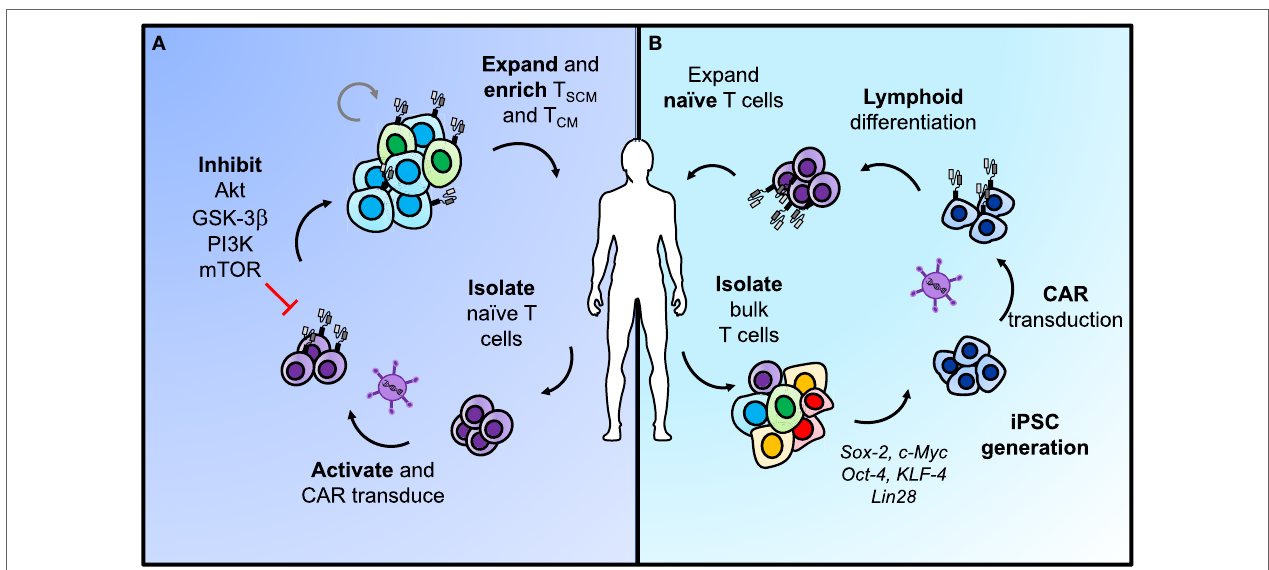
FigURe 4 | Two approaches for generating less-differentiated T cells after ex vivo expansion for adoptive cell transfer. (A) Naïve T cells sorted from peripheral blood can be activated and transduced with chimeric antigen receptors (CARs) for antigen specificity. Adding pharmacologic inhibitors of AKT, GSK-3 β , PI3K, or mTOR to the T cell culture helps retain cells in a less-differentiated state as they expand. This approach can enrich T SCM and T CM phenotypes in CAR T cells from naïve populations before adoptive transfer to enhance long-term immunity. (B) Differentiated T cells can be reprogrammed with stem-like qualities using iPSC technology. In brief, bulk T cells are isolated from the blood, programmed into iPSCs, and transduced with a CAR before lymphoid differentiation into naïve T cells. The most efficient approaches for lymphoid differentiation into naïve phenotypes are still under